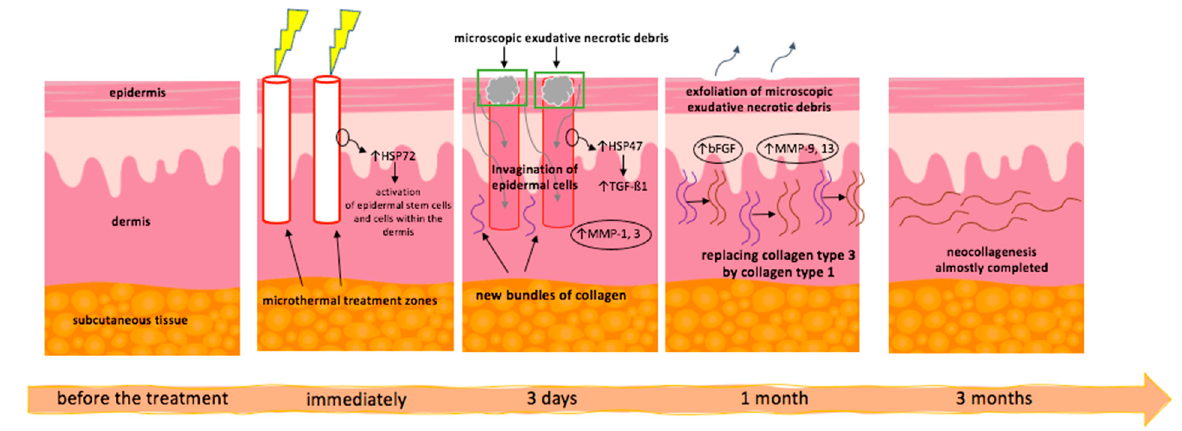
Figure 2. The mode of action of fractional lasers [32,44,47].